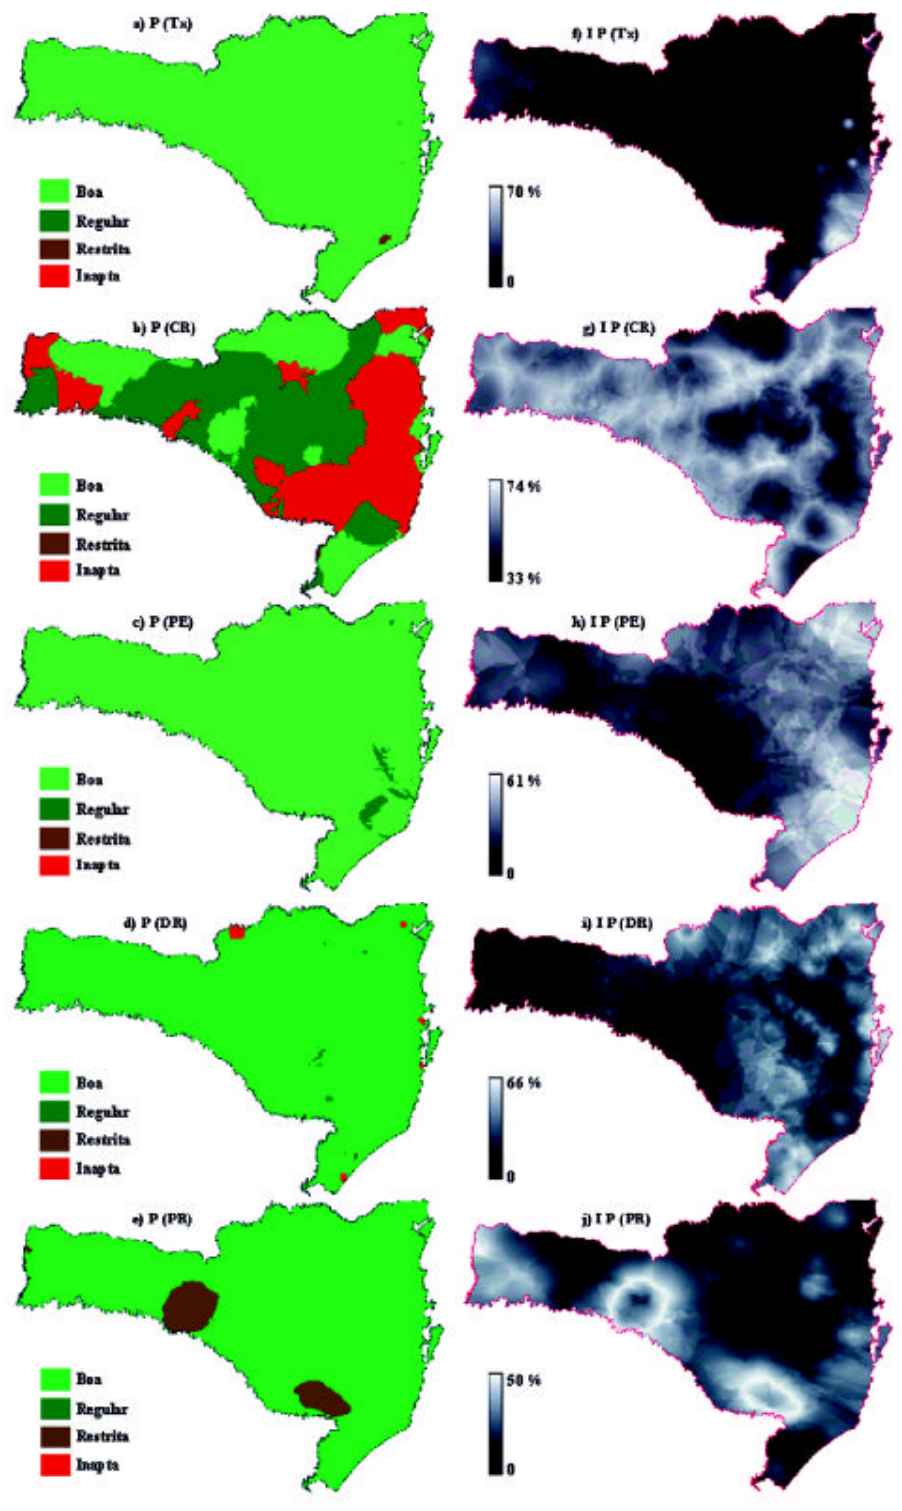
Figura 3. Espacialização das variáveis de solos: classe de textura, classe de relevo, profundidade efetiva, classe de drenagem e classe de pedregosidade/rochosidade, expressas por atributos categóricos de aptidão pedológica [Pƒ(Tx), Pƒ(CR), Pƒ(PE), Pƒ(DR) e Pƒ(PR)], e incertezas associadas [I[Pƒ(Tx)], I[Pƒ(CR)], I[Pƒ(PE)], I[Pƒ(DR)] e I[Pƒ(PR)]], com a legenda do mapa de incertezas, em escala de cinza, indicando a probabilidade (em percentagem) de que a classe do atributo considerado exceda a classe definida como mais